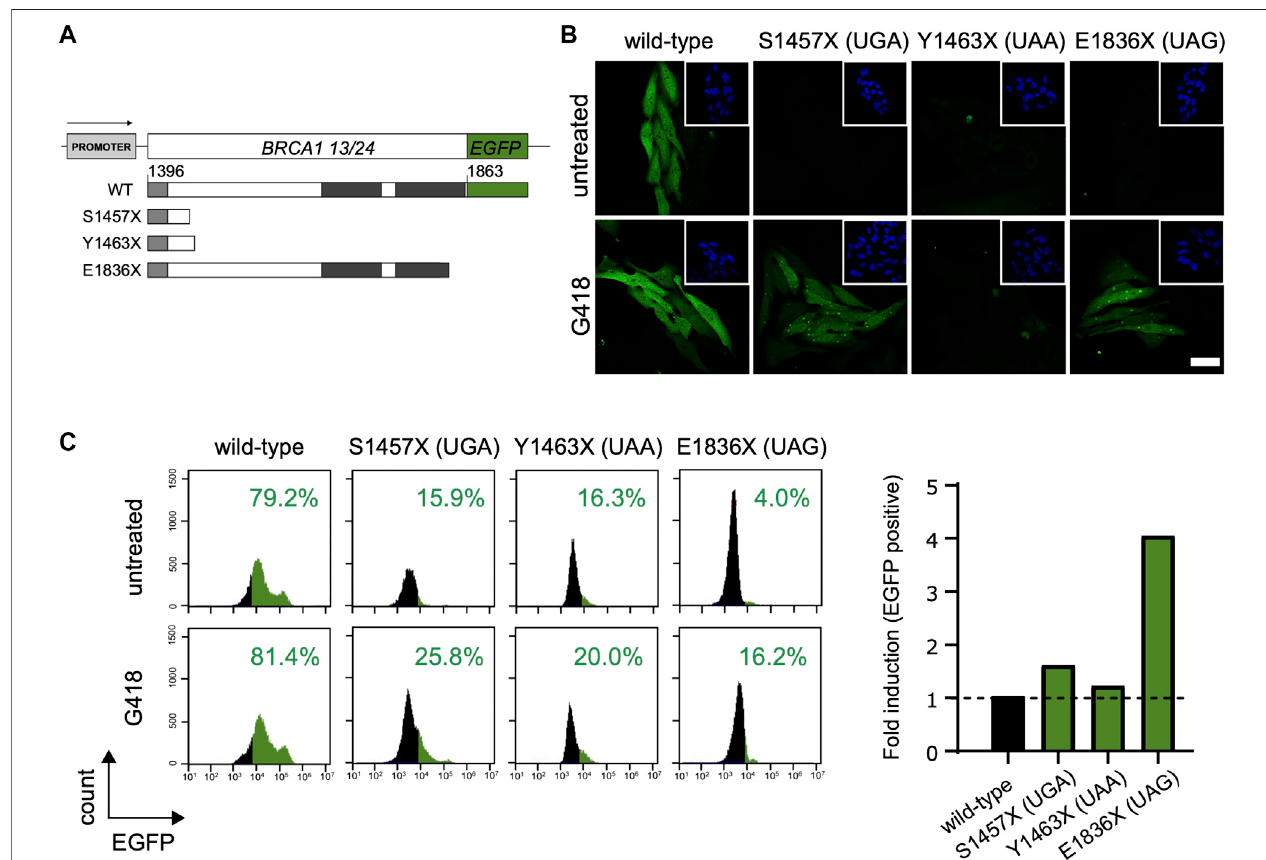
FIGURE2 | BRCA1 PTC readthrough evaluationin different stop codons. (A) Schematic representation ofBRCA1-EGFP construct encoding amino acid residues 1,396 to 1,863 (corresponding to exons 13 to 24; BRCA1 13/24; upper panel). WT and PTC truncated proteins (lower panel) are represented; coiled-coil domain is indicated in lightgrey and the tBRCT indicated in dark grey. (B) Fluorescence confocal microscopy for HeLaBRCA1-EGFP cells encoding WT sequence or the different PTC variants. Cells wereeither untreated ortreatedwith G418(300 μ g/ml) for48 h and EGFP fl uorescence wasevaluated. Scale bar:20 μ M. (C) FACS analysisof HeLaBRCA1-EGFPcellsencodingWTsequenceordifferentPTCvariants.Leftpanel:FACShistograms.Rightpanel:graphicalrepresentationofEGFPfoldinductionof G418 treated cells relative to untreated cells. Representative data from 3 independent